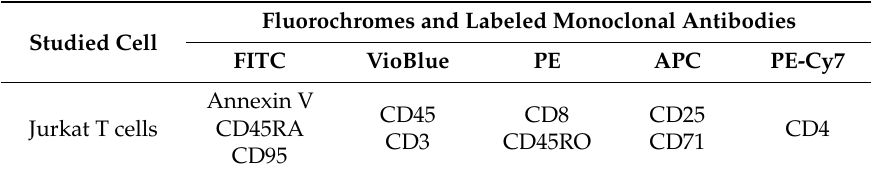
Table 1. Monoclonal antibody panel used for the estimation of Jurkat T cell viability and antigen profiles. Fluorochromes and Labeled Monoclonal Antibodies Studied Cell